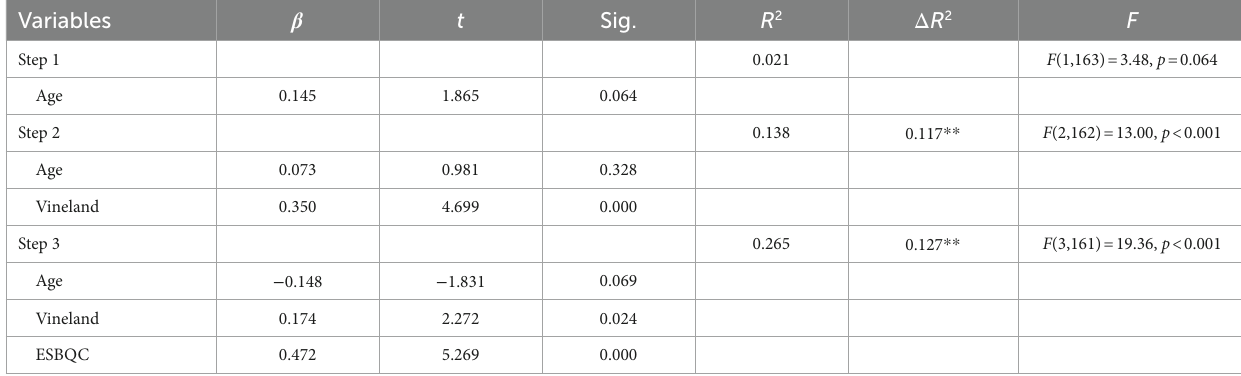
TABLE 4 Regression results on